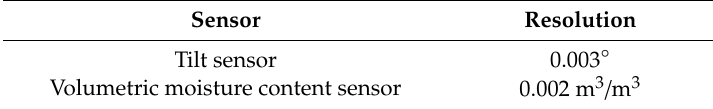
Table 1. Specifications of tilt sensor and volumetric moisture content